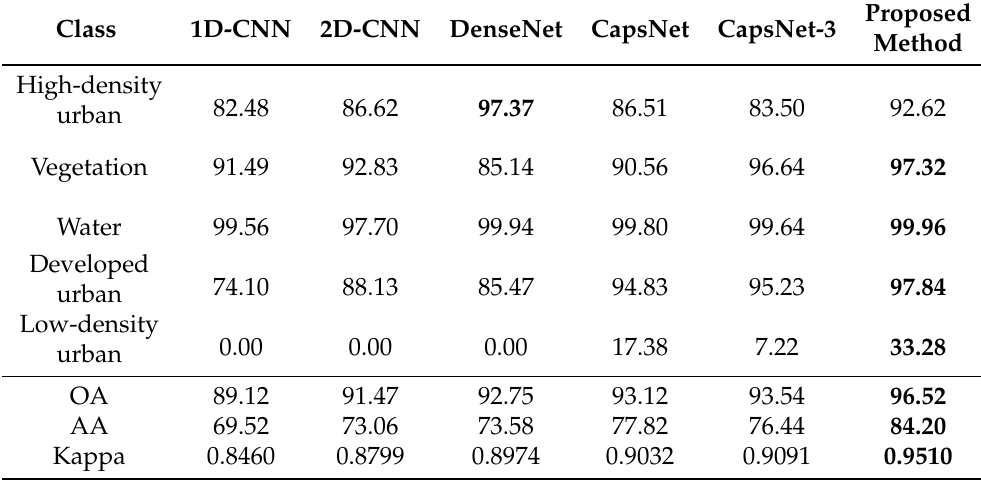
Table 7. Classification accuracy (%) of the AIRSAR San Francisco